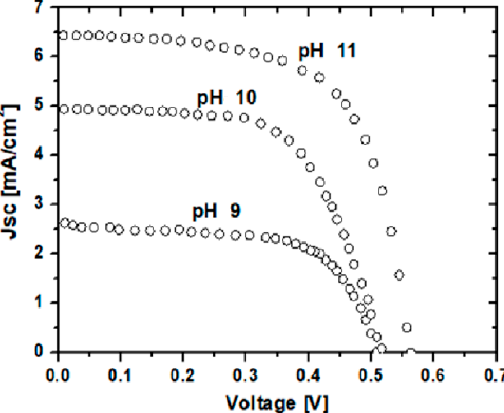
Figure 7. J-V curves of nanostructure-based dye-sensitized solar cells.